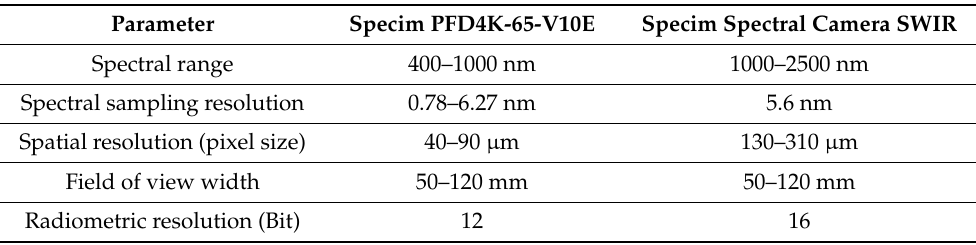
Figure 1. Specim Single Core Scanner showing measurement principle and example of relative ab- sorption band depth indices (RABD 670 for chloropigments a and RABD 845 for bacteriopheophytin a ). Table 1. Summary of technical specifications for hyperspectral cameras available for sediment core scanning (Spectral Imaging Ltd., Oulu,